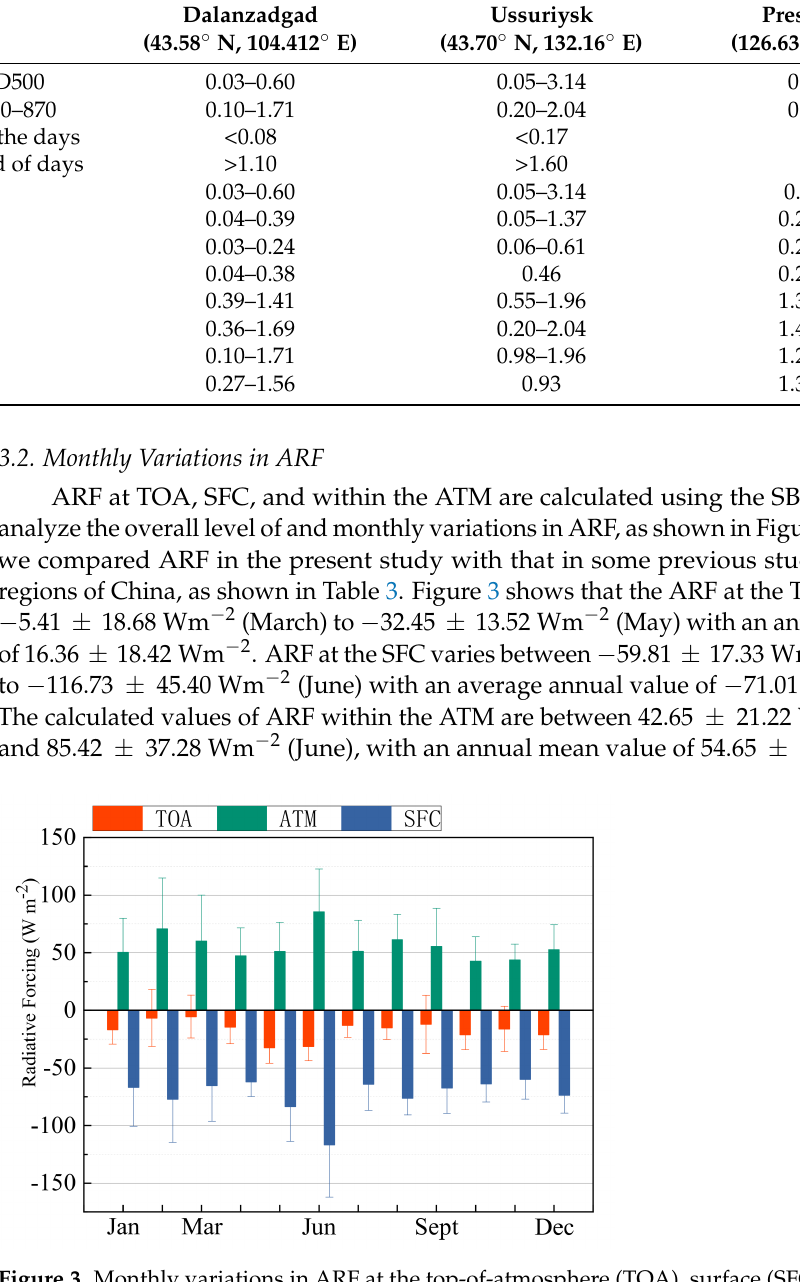
Figure 3. Monthly variations in ARF at the top-of-atmosphere (TOA), surface (SFC), and within the atmosphere (ATM) in